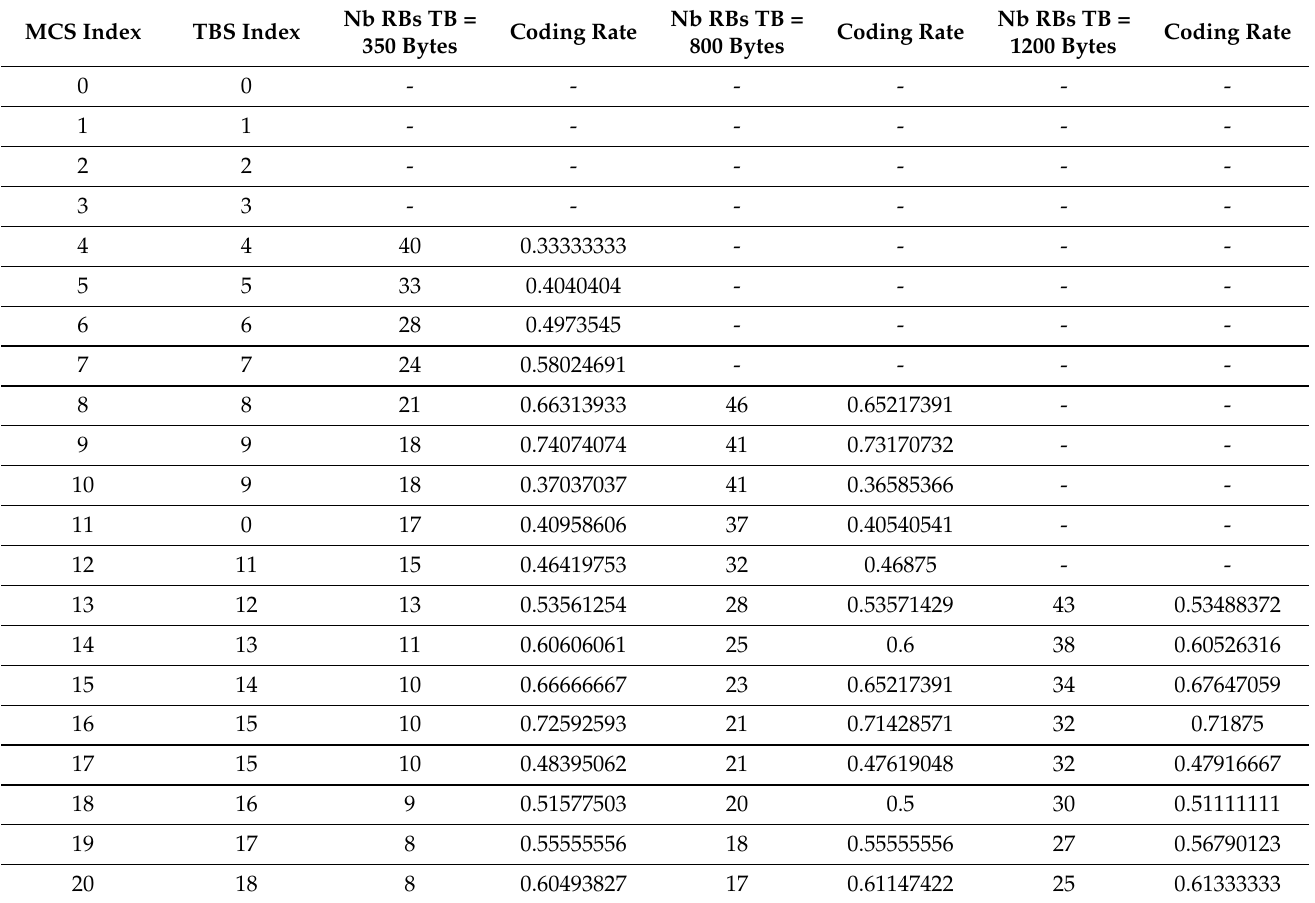
Table 3. Coding rate and RBs required for different Transport Block (TB)